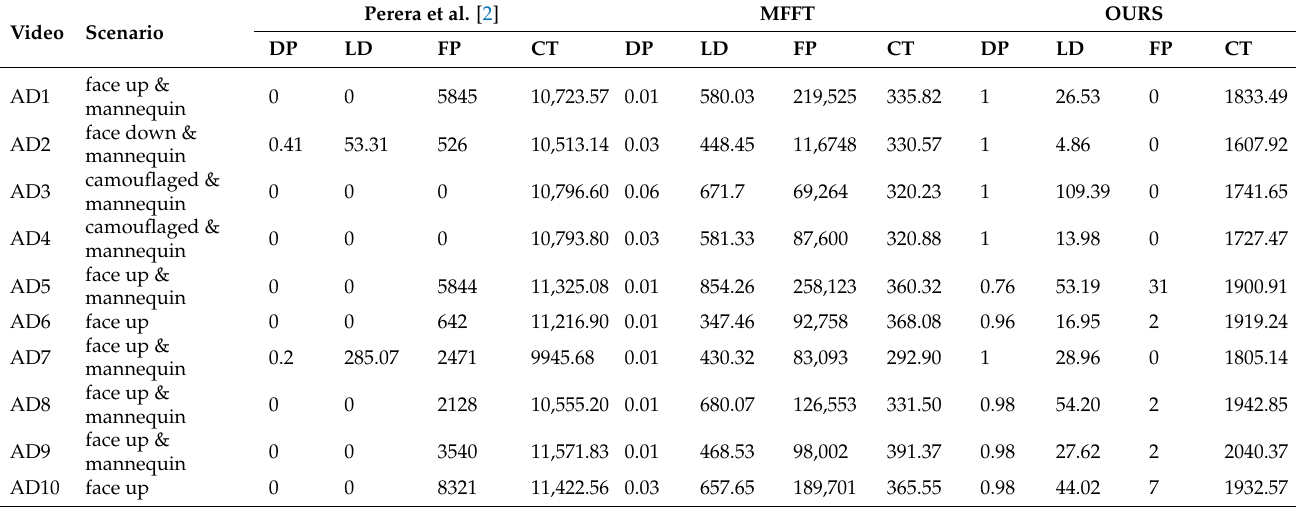
Table A1. Results of detection precision DP , location density LD ( ‰ ) , number of false detected points FP and computational time CT ( s ) of Perera et al.’s work [2], MFFT and ours for ten drone videos (AD1 to